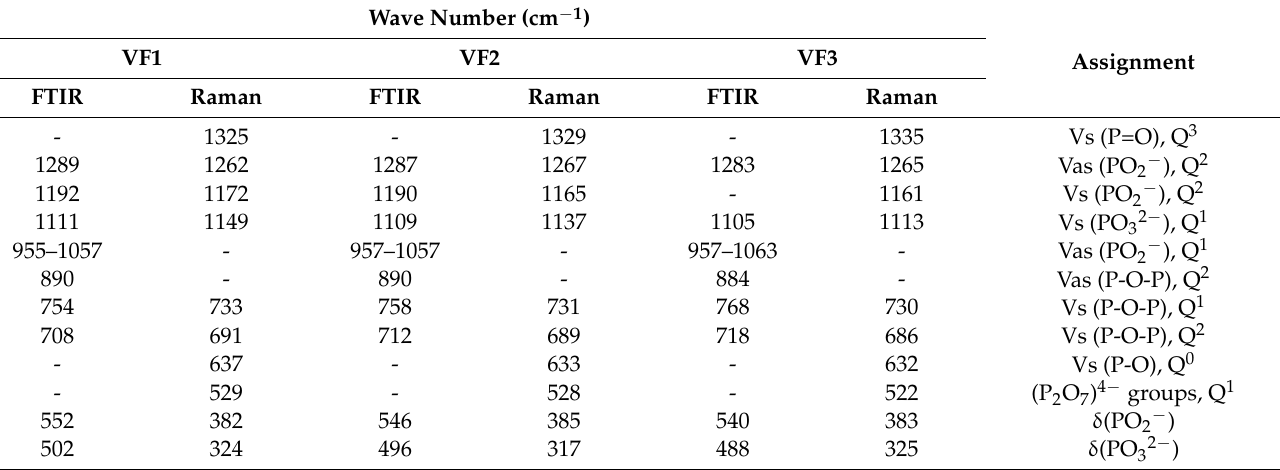
Table 3. Assignments and frequency ranges (cm − 1 ) of the FTIR and Raman bands for concentrations of [K 2 O/(CaO+MgO)] ratio (%mol). VF1: 0.67 %mol, VF2: 1.33 %mol and VF3: 2 %mol.